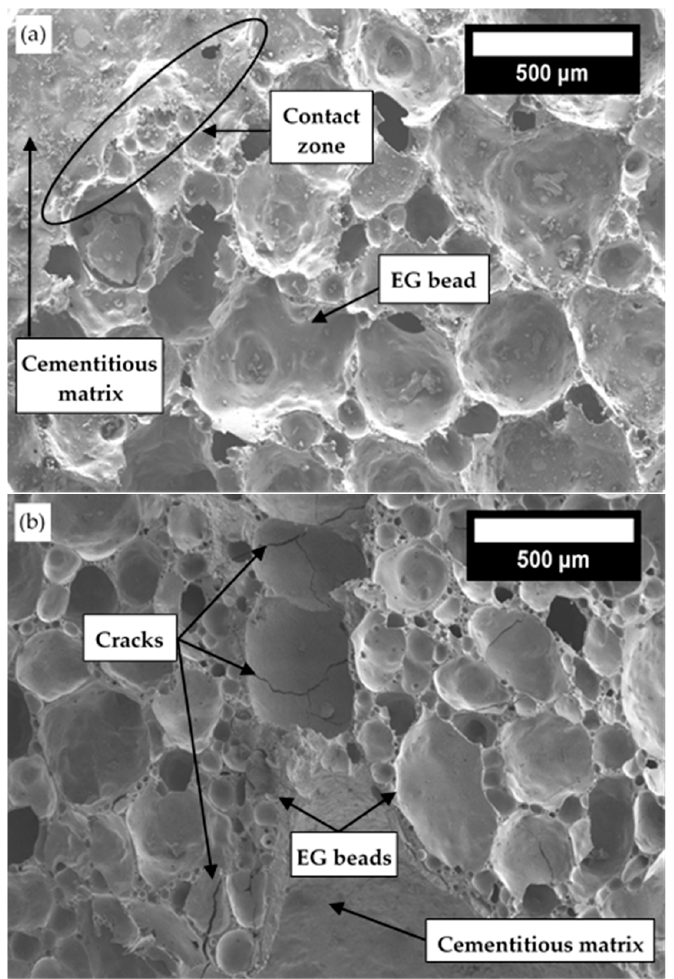
Figure 10. View of the LWC with EG aggregate: ( a ) before freezing test; ( b ) after 200 freeze–thaw cycles.